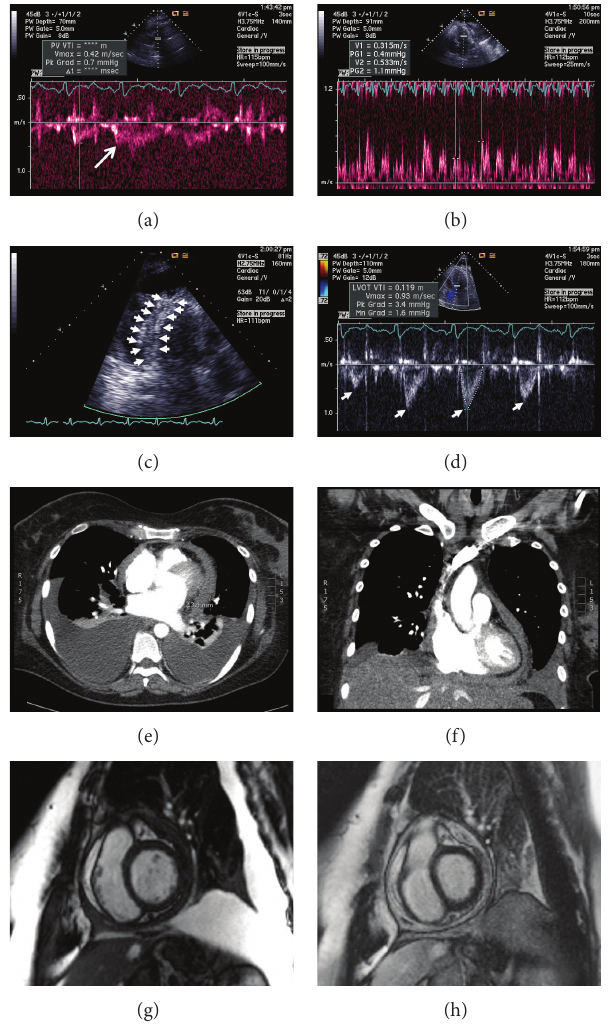
Figure 1: Imaging findings consistent with constriction. Initial transthoracic echocardiography shows Doppler spectral revealing a presystolic flow (white arrow) through the pulmonic valve due to premature opening of the valve (a), exaggerated respiratory variation of the mitral valve inflow (b), an apical 3-chamber view of the thickened pericardium (outlined by arrows) around the inferolateral/posterior wall of the left ventricle (c), and exaggerated left ventricular outflow tract flow variation (arrows) (d). Cardiac CT with contrast demonstrates axial (e) and coronal (f) images of the markedly thickened pericardium measuring 13.4mm and pleural effusion. Cardiac MR also demonstrates the thickened pericardium in the T2-weighted bright blood imaging (g) and the intense late gadolinium enhancement of the pericardium without myocardial involvement